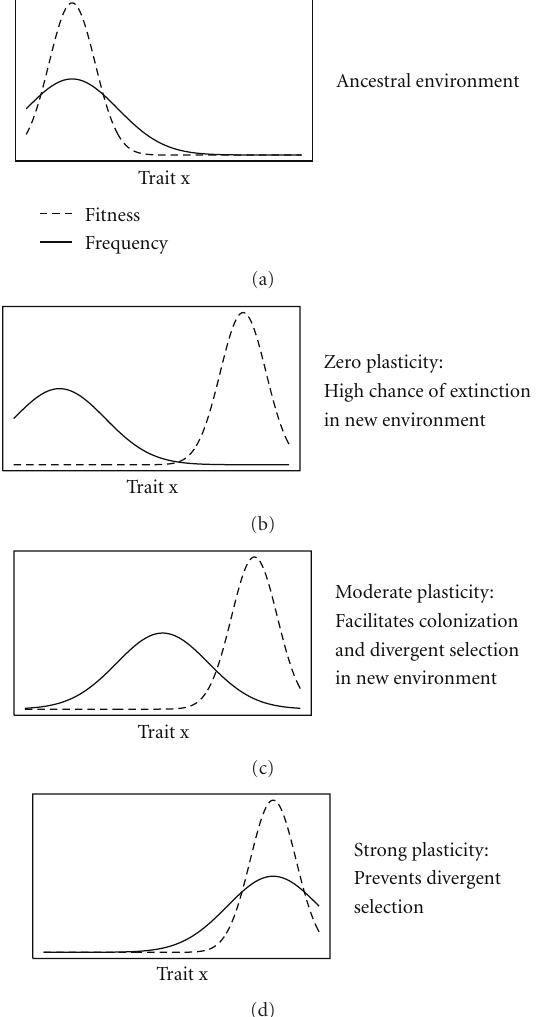
Figure 2: E ff ects of adaptive plasticity on colonization and adaptation to a new niche. A population well adapted to its niche is illustrated in (a) by coincidence of the mean trait value (black line) with the peak of the fitness function (dashed line). If the fitness function is dramatically di ff erent in a new environment, a population with trait values favored in the old environment (b) might have such low fitness as to have little chance of survival. If environmental induction produces a shift in trait values toward higher fitness phenotypes (c), the population might persist but still experience selection. If phenotypic plasticity results in a perfect match between mean trait value and fitness optimum (d), then there is no e ff ect of selection on the population